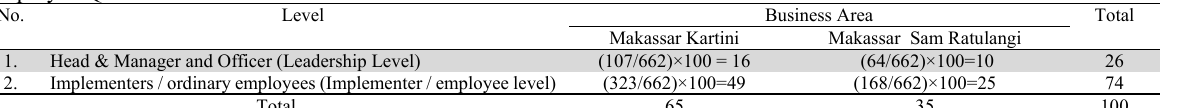
Fig. 2. SEM-PLS Measurement Model (Outer Model)